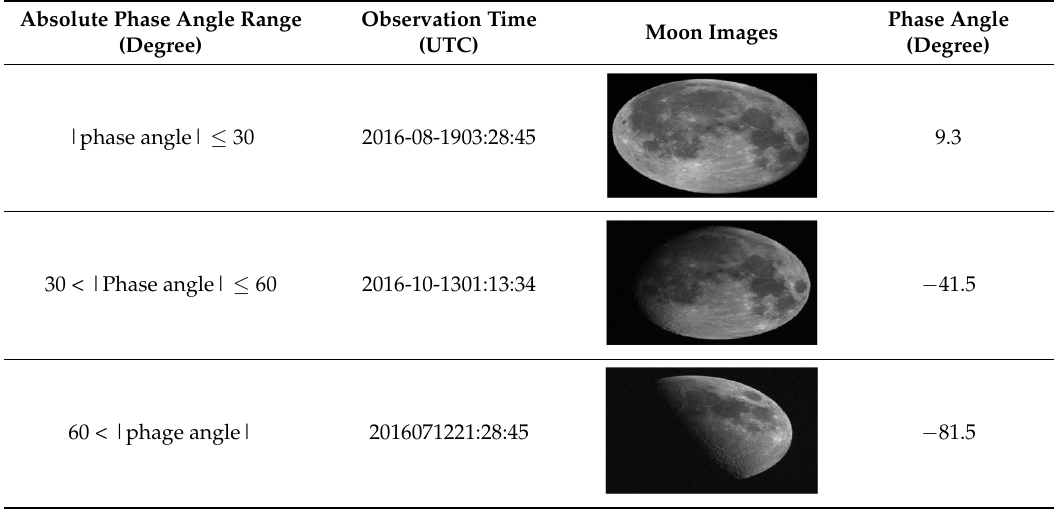
Table A1. Example of Moon image with three phase angle